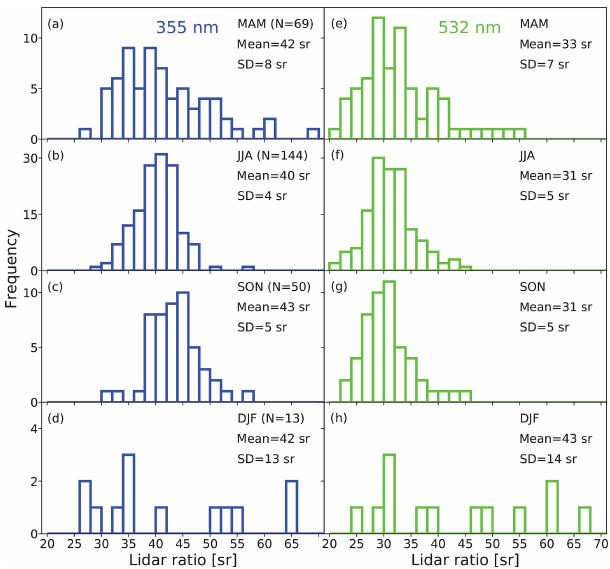
Figure 2. Histograms of layer-mean particle linear depolarization ratio at (a–d) 355nm (blue) and (e–h) 532nm wavelength (green) per season for (a, e) spring, (b, f) summer, (c, g) autumn, and (d, h) winter. (a–d) The number of observations per season is given in brackets. In addition, seasonal mean values and standard deviations are listed.